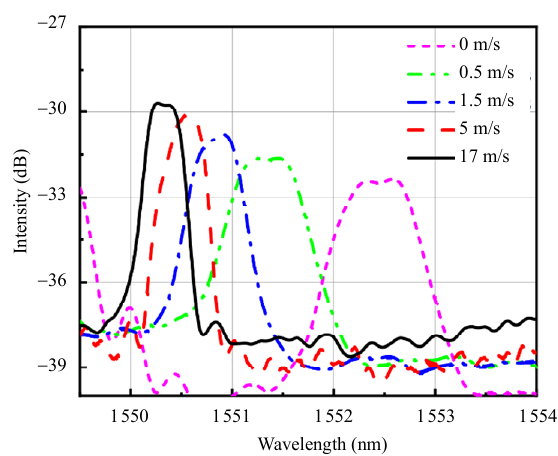
Fig. 4 Reflection spectra of the etched FBG anemometer under various airflow velocities.